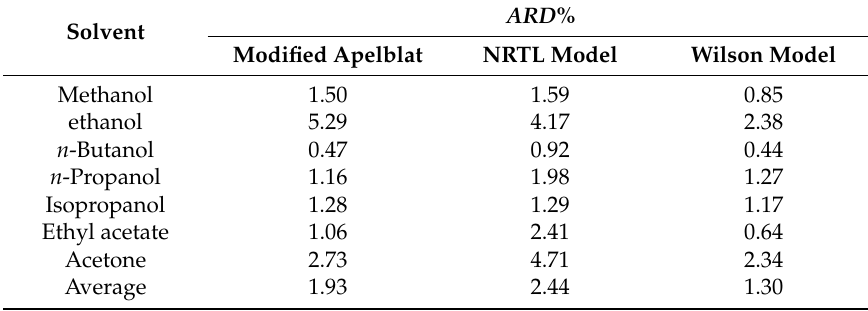
Table 4. The average relative deviation ( ARD %) of models for solubilities in different